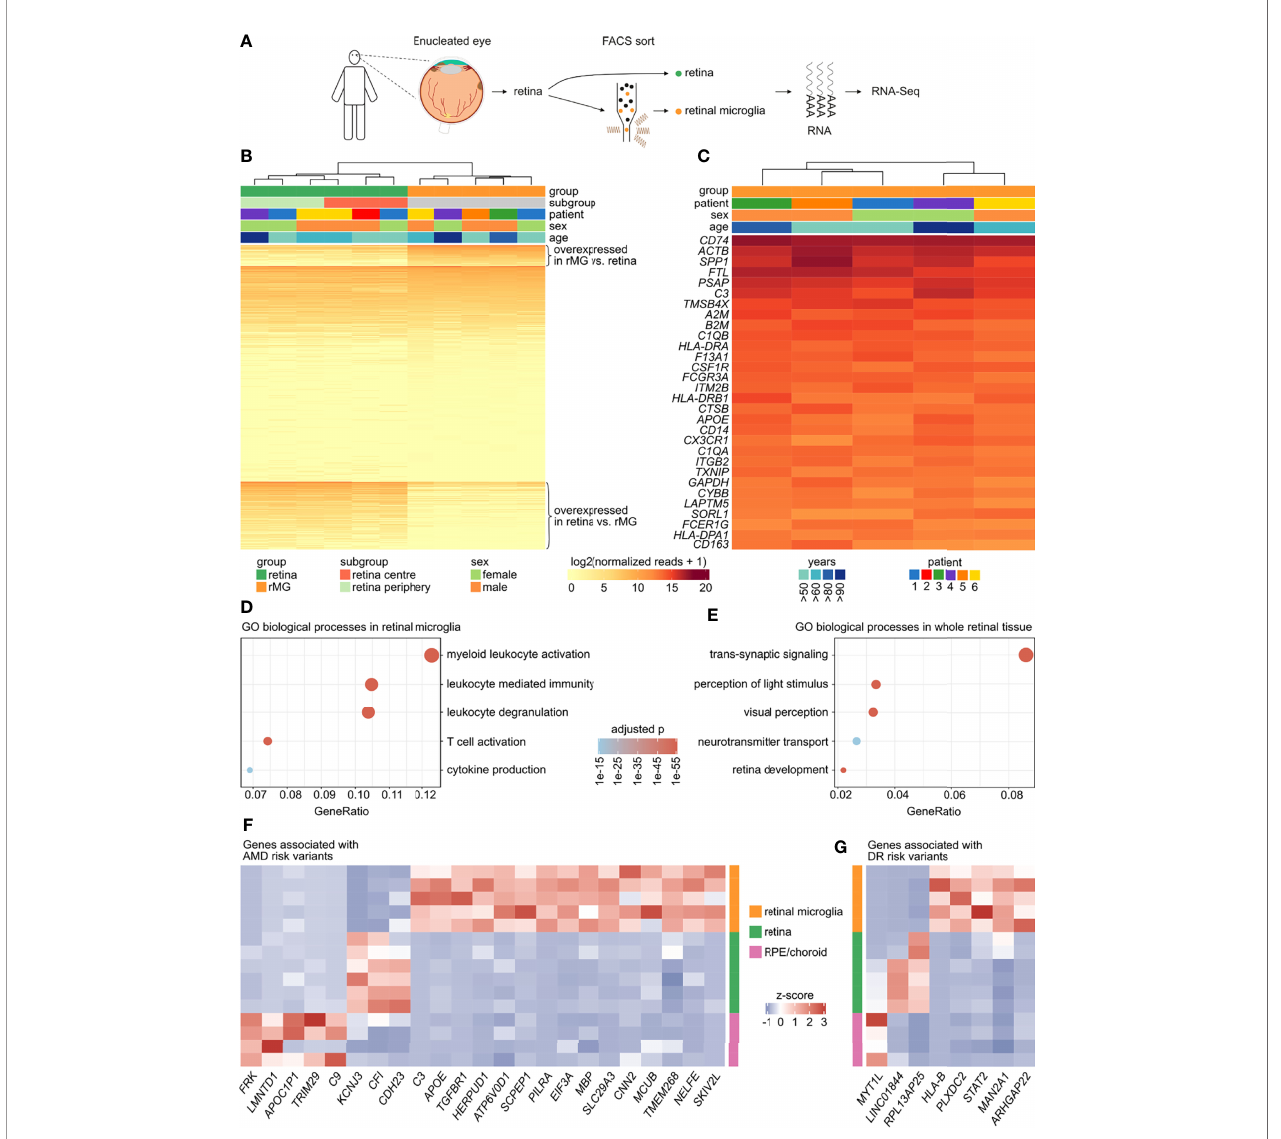
FIGURE 1 | Transcriptional characterization of human retinal microglia. (A) Retinal tissue as well as FACS-isolated retinal microglia (CD45 + CD11b + CX 3 CR1 + MatMac + CCR2 - ) were analyzed by RNA sequencing. (B) Heatmap comparing the expression pro fi le of 34,605 genes expressed in whole retinal tissue in comparison to sorted retinal microglia. Enriched transcripts (logFC > 2 and adjusted p < 0.05) in retinal microglia (n = 2,433) as well as in retina (n = 7,798) are shown at the top or the bottom of the heatmap, respectively. The genes with similar expression in both groups are shown in the center (n = 24,374). Genes are ordered according to mean expression in the respective group. rMG = retinal microglia. (C) Heatmap visualizing the top 30 genes of the retinal microglia gene signature (from B). (D, E) Dotplots visualizing the top fi ve Gene ontology (GO) biological processes in retinal microglia (D) and in whole retinal tissue (E) . The GeneRatio represents the proportion of associated genes to the total number of overexpressed genes. The adjusted p-value of each GO term is shown by color. (F, G) Heatmaps visualizing the expression of risk genes associated with age- related macular degeneration (AMD) (F) or diabetic retinopathy (DR) (G) , which were enriched in retinal microglia, retina or retinal pigment epithelium (RPE)/choroid tissue (logFC > 2 and adjusted p < 0.05 for both comparisons each). The z-score represents a gene ’ s expression in relation to its mean expression by standard deviation units (red: upregulation, blue: